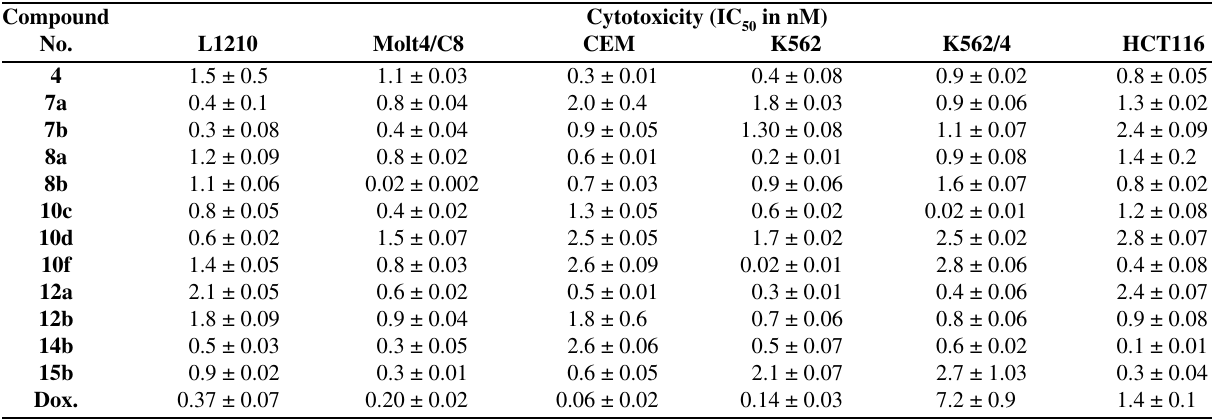
) of selected compounds against variety of cell lines 50